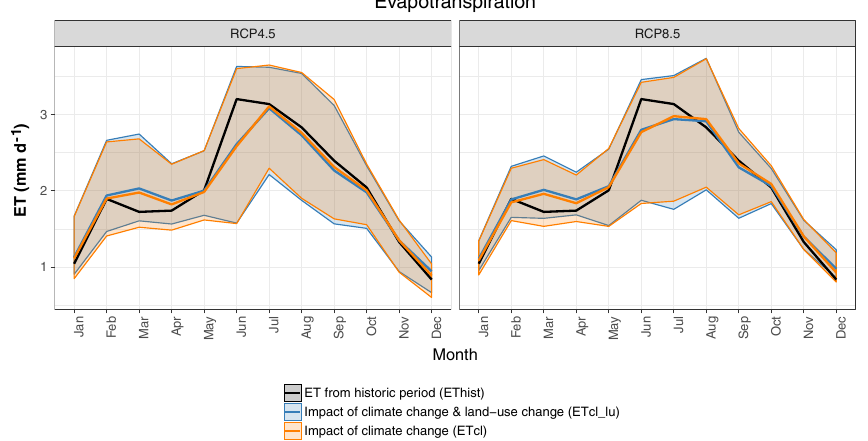
Figure 12. Multi-model mean values of the evapotranspiration (ET) fluxes simulated by JULES for the Upper Ganges basin and for each of the emission scenarios (RCP4.5 and RCP8.5). Black colour corresponds to the historical simulation period 2000–2005 ( ET hist ) . Orange colour corresponds to the simulation period 2030–2035, when only climate change is taken into account ( ET cl ) . Blue colour corresponds to the simulation period 2030–2035, when both climate change and land-use change are taken into account ( ET cl_lu ) . Shaded areas correspond to the maximum and minimum evapotranspiration values obtained from different GCM forcings and illustrate the large CMIP5 model